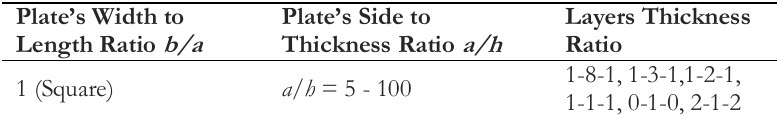
Table 1. Plate’s Geometry to be